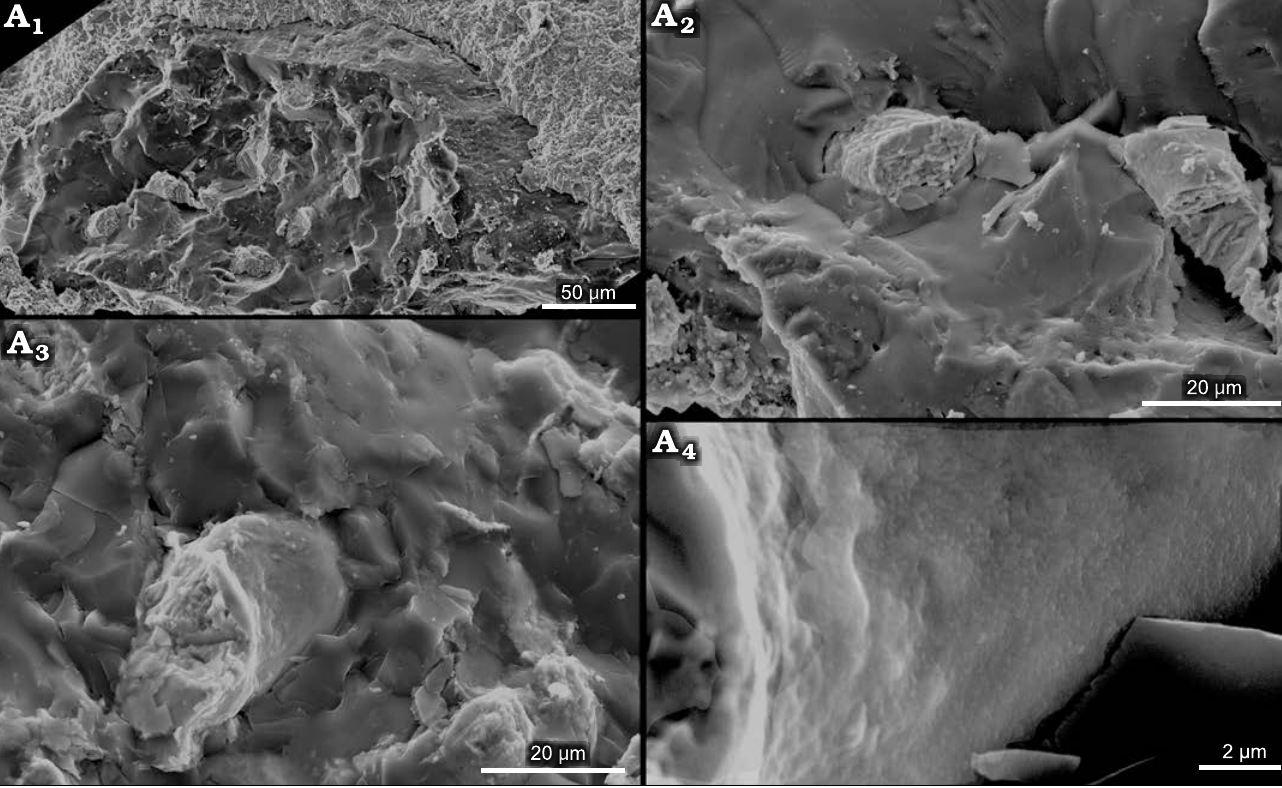
Fig. 8. Hypothesized “beak” of the coleoid cephalopod Phragmoteuthis bisinuata (Bronn, 1859) (GBW 2006/011/0009), lower Carnian, Upper Triassic, Cave del Predil, NE Italy. A fracture of the “beak”. A 1 , a dimpled outer surface of the “beak” coated by a shale; A 2 , “glassy” structureless matrix and whitish fractured compressed bone-like nanostructure; A 3 , dense wall of bone-like nanostructure; A 4 , a dimpled outer surface of the wall of the bone-like